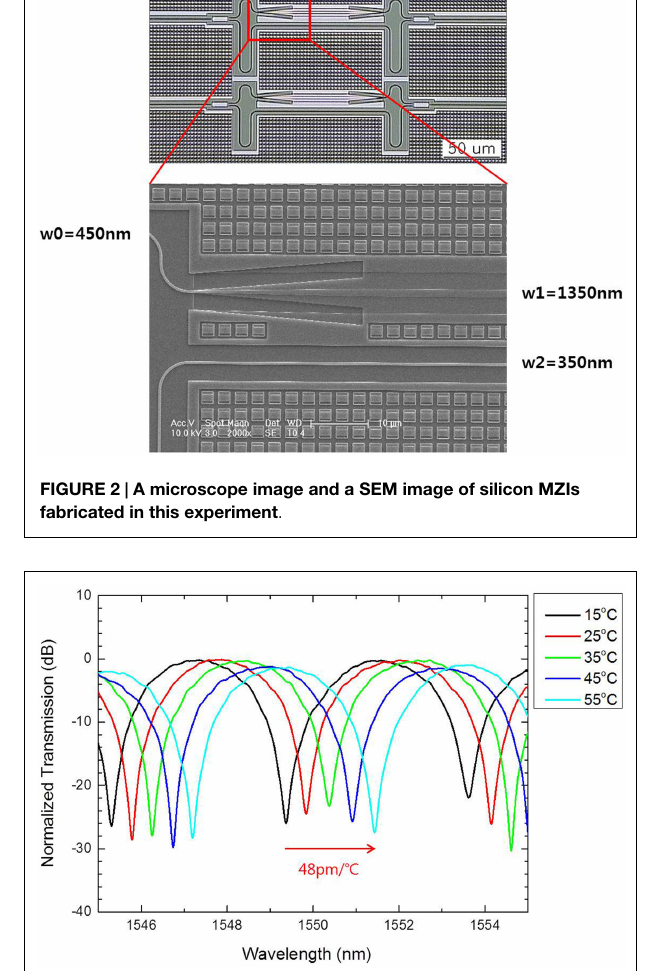
FIGURE 3 | Normalized transmission spectra of MZI with silica cladding as the temperature varied from 15 to 55°C when L = 360 μ m, w1 = 1350nm, and w2 = 350nm